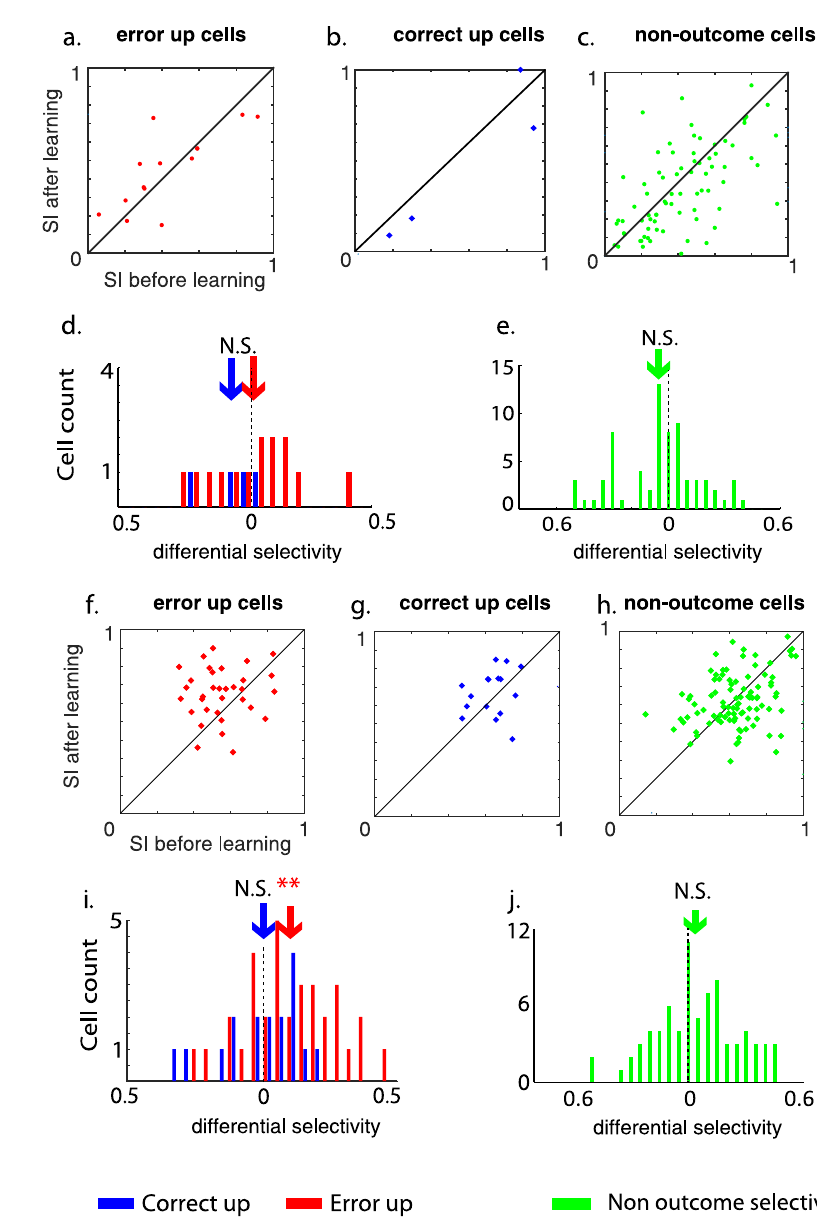
Fig. 4 Error-up cells in EC increased their selectivity index (SI) after learning. The SI during the delay period before versus after learning of the same error-up ( a ), correct-up ( b ), or non-outcome-selective neurons ( c ) in HPC are plotted against each other. The distribution of differential SI before and after learning for the error-up and correct-up cells ( d ) and non-outcome-selective cells ( e ) in HPC are also plotted to indicate no signi fi cant shift in the differential SI in HPC. The same information for cells in the EC is shown in f – j . In i the differential SI of error-up cells shows a signi fi cant right-ward shift. Arrows indicate the averaged differential selectivity of each population. ** p < 0.005. The vertical dashed lines in d , e , i , and f indicate no differential selectivity. All data points are shown in Supplementary Data